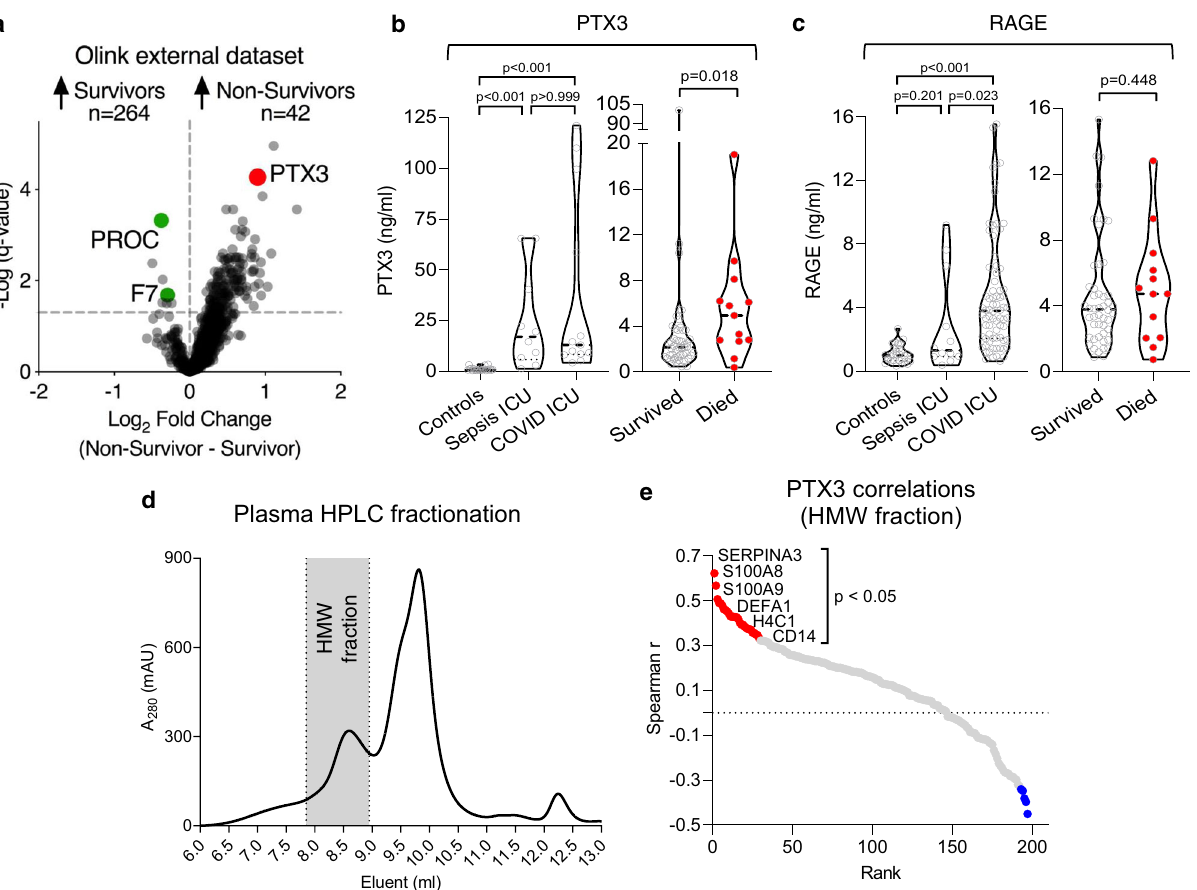
Fig. 4 External protein marker validation and PTX3 selection. a PTX3 was among the proteins most strongly associated with poor outcome among 1472 unique plasma proteins (Data provided by the MGH Emergency Department COVID-19 Cohort (Filbin, Goldberg, Hacohen) with Olink Proteomics) 38 . Of the 10 proteins we found to be associated with outcome in our DIA – MS data (Fig. 3c, d), PROC and F7 were the only proteins also measured in the external validation data, con fi rming an inverse association with mortality. The log2FC (adjusted for categorical age) was higher for PTX3: 0.8, adjusted P value = 0.00044 compared with PROC: − 0.4, adjusted P value = 0.0006 and F7: − 0.3, adjusted P value = 0.03. b PTX3 measurements by ELISA (KCH and GSTT samples for COVID-19-ICU cohorts in left and right panel, respectively). c ELISA measurements for RAGE, as an established marker for ARDS. d High- performance liquid chromatography (HPLC) fractionation of plasma ( n = 35-time points from 13 patients, KCH). PTX3-containing high molecular weight (HMW) fraction is shaded in gray. A 280 denotes the absorbance of the eluent at 280 nm. e Proteomics analysis of the HMW fraction. Signi fi cant Spearman correlations of PTX3 with neutrophil- and macrophage-related proteins. All statistical analyses are